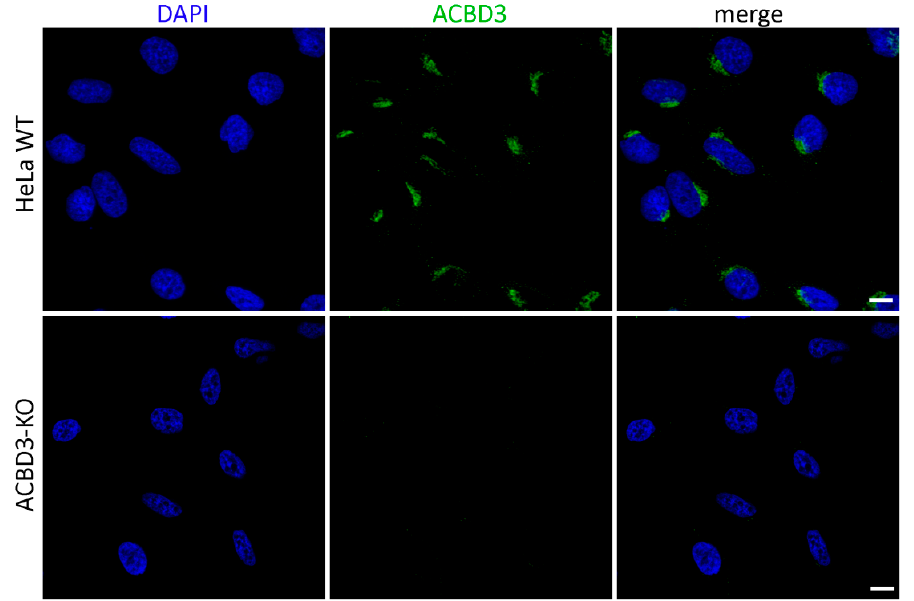
Int. J. Mol. Sci. 2021 , 22 , x FOR PEER REVIEW 18 of 22 Figure A1. Confocal immunofluorescence images of ACBD3 antibody in HeLa WT and ACBD3-KO cell lines. Scale bar 10 µm.